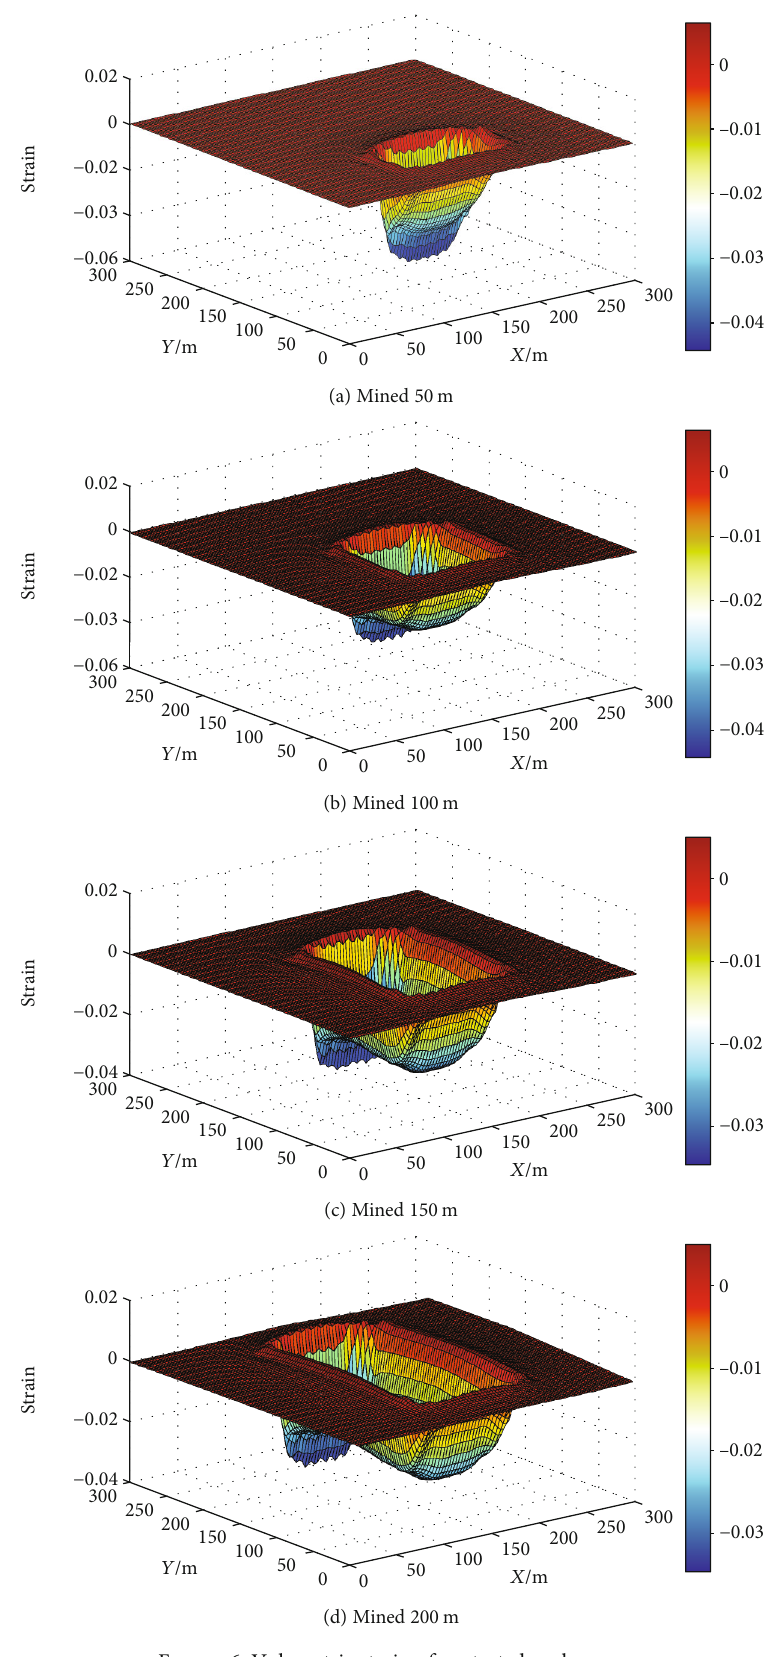
Figure 6: Volumetric strain of protected coal